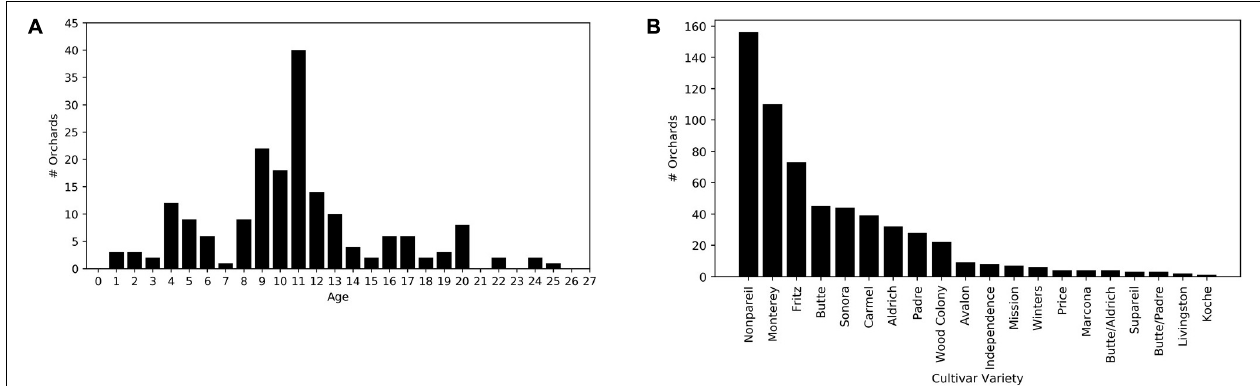
FIGURE 2 | Distributions of (A) orchard age in 2017 and (B) cultivars for the study orchards ( N =